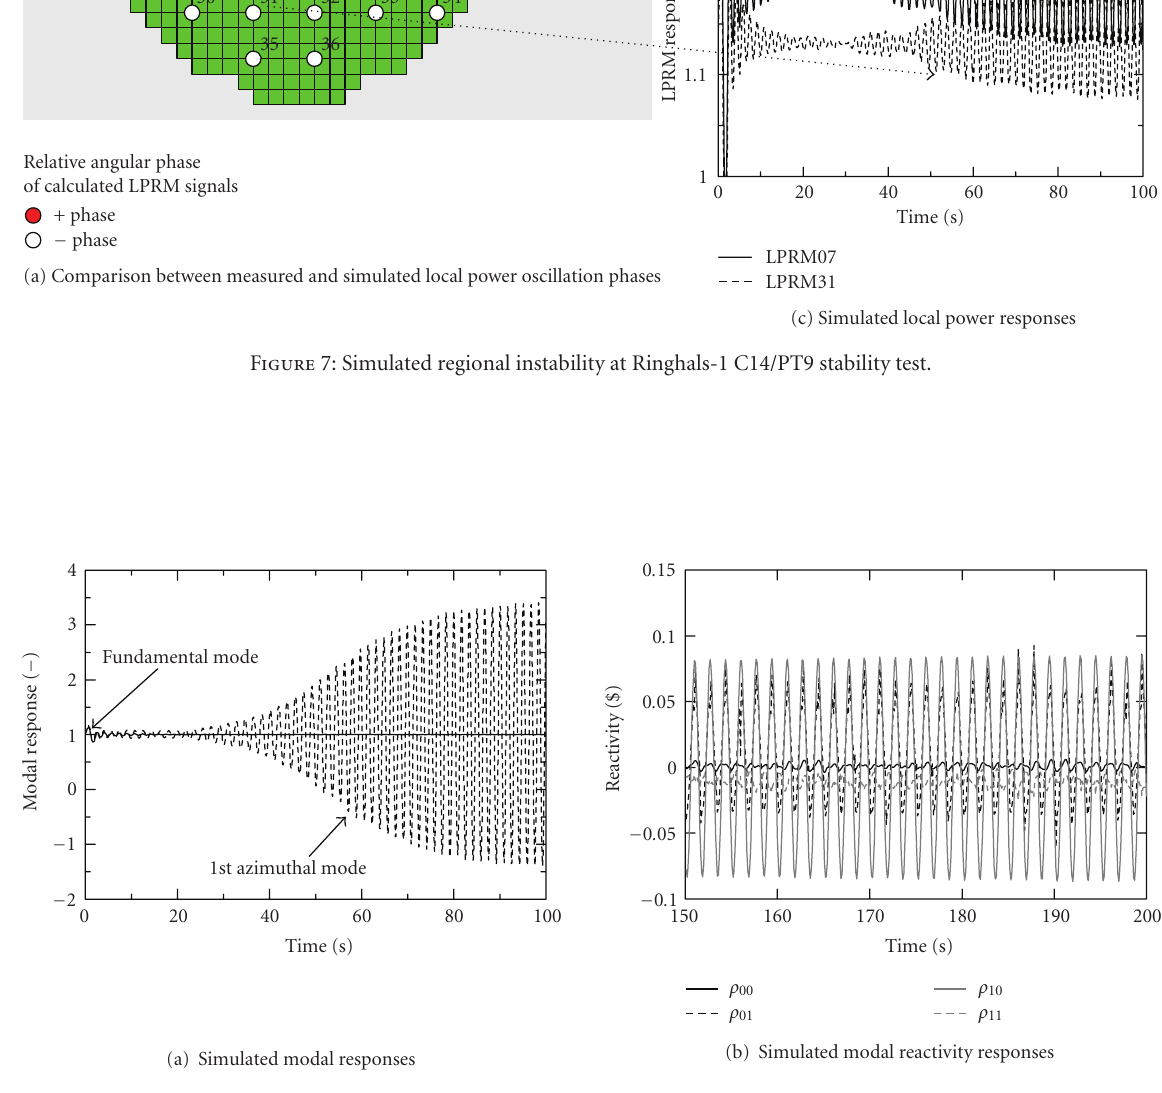
(b) Simulated core-averaged power response